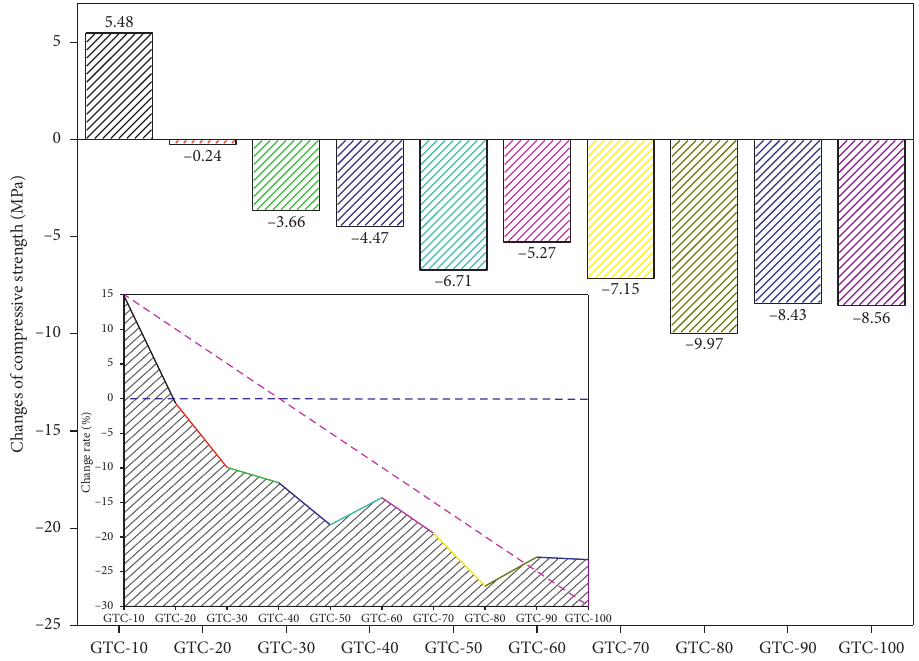
Figure 4: Changes of compressive strength of GTC (0% to 100%).